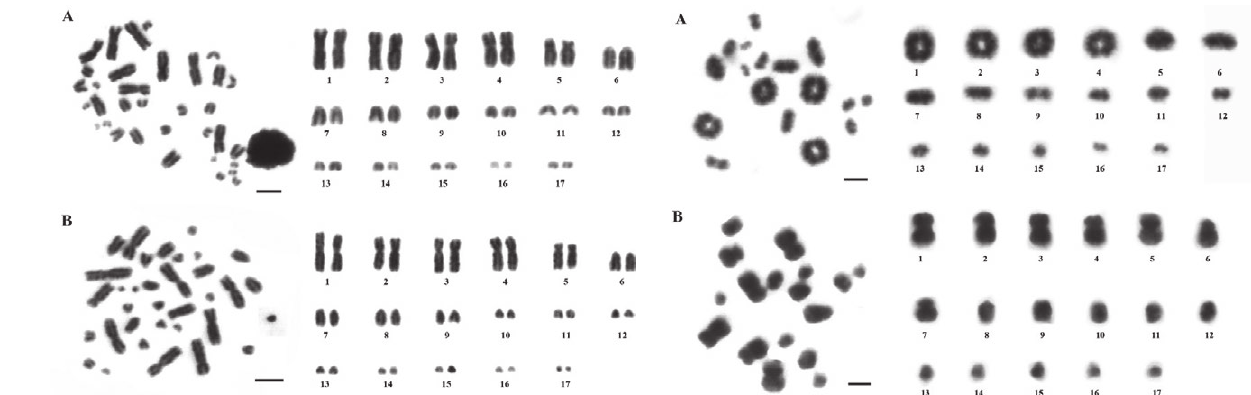
Figure 2. Metaphase chromosome plates and karyotypes of G. nuta- phandi (A) Metaphase I (B) Metaphase II by conventional tech- nique. Scale Bars = 10